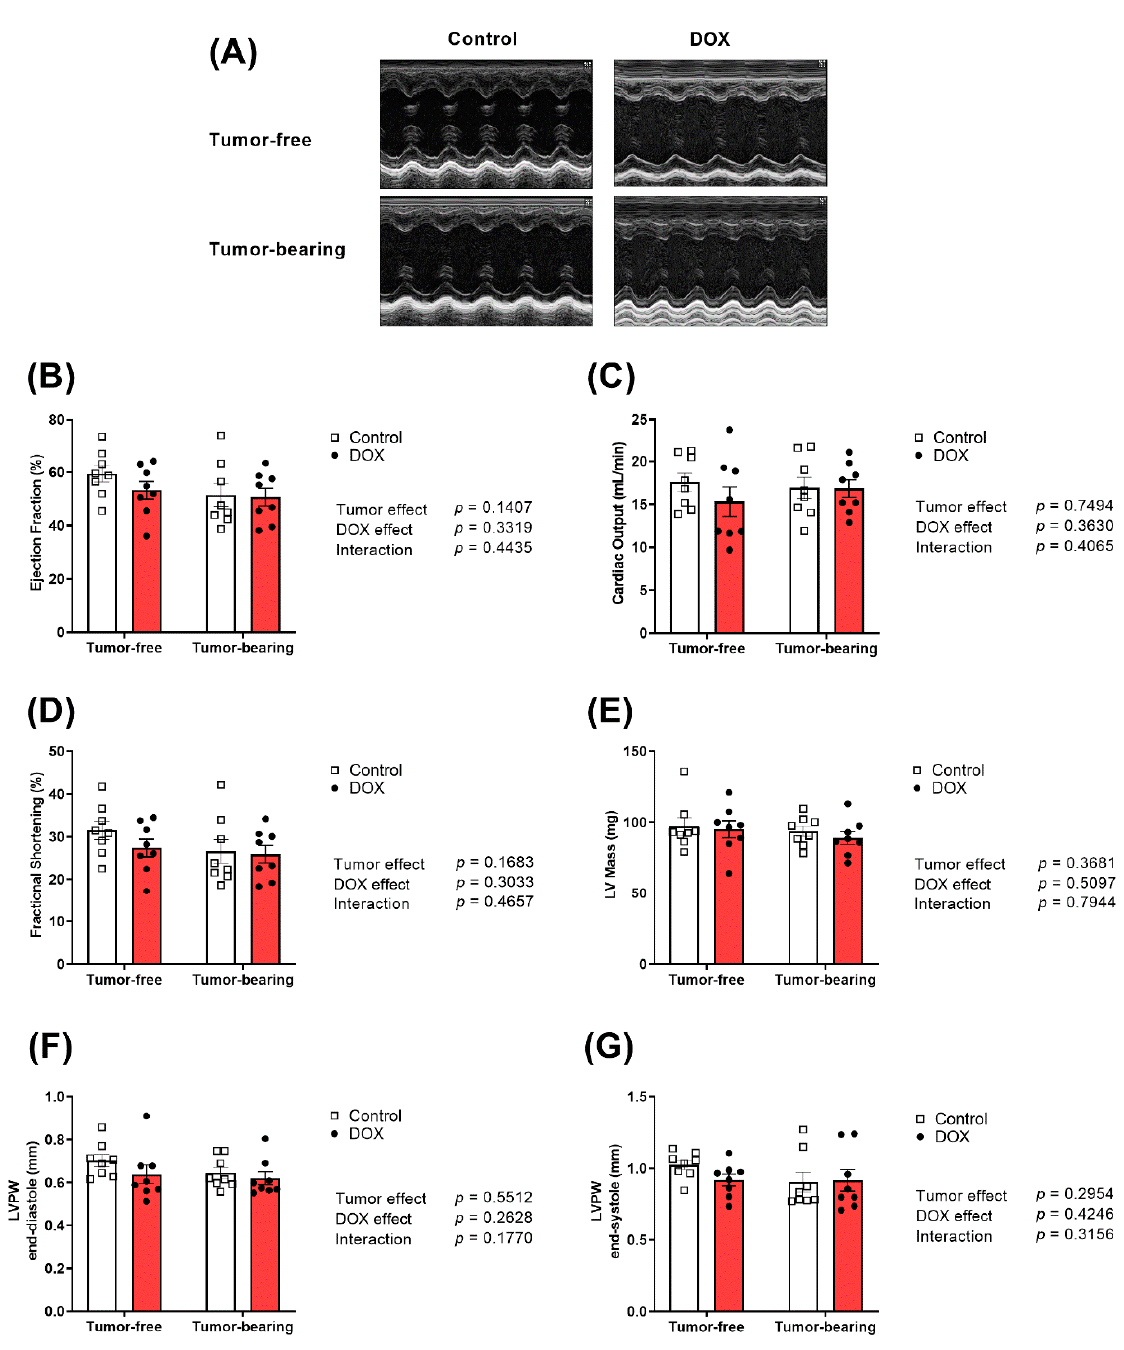
Figure 2. Chronic administration of DOX (4 mg/kg/week) for 3 weeks causes a similar cardiac response in tumor-free and tumor-bearing juvenile mice. Tumor-free and EL4 lymphoma tumor-bearing juvenile C57BL/6N male mice were administered intraperitoneal DOX (4 mg/kg/week) or saline for 3 weeks. Cardiac function was assessed by transthoracic echocardiography one week following the last injection ( n = 8 per group). ( A ) Representative images from parasternal short axis view of the heart acquired in M-Mode. Effects of DOX and the tumor on ( B ) ejection fraction, ( C ) cardiac output, ( D ) fractional shortening, ( E ) left ventricular (LV) mass, ( F ) LV posterior wall during diastole, and ( G ) LV posterior wall during systole. Values are shown as means ± SEM. Two-way ANOVA was used to determine the main effects of DOX, tumor, and interaction. Statistical significance of pairwise comparisons was determined using two-way ANOVA with Tukey’s post hoc analysis.